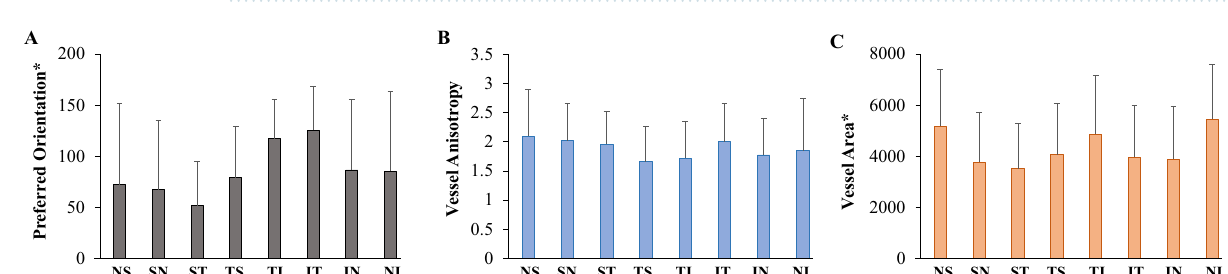
Figure 6. Sectoral difference in retinal microvascular pattern in healthy subjects (n = 34). Significant sectoral differences were observed in preferred orientation (p < 0.0001) and vessel area (p < 0.0001), whereas vessel anisotropy did not show a significant difference among the 8 sectors (p = subjects (SN: 67.2° ± 68.4° for healthy vs 62.2° ± 77.1° for DR; ST: 51.7° ± 43.1° for healthy vs 49.4° ± 31.2° for DR). The largest difference in preferred orientation between healthy and DR was observed in the IN sector (86.8° ± 69.1° for healthy vs 157.2° ± 29.4° for DR, p = 0.005). It is worth noting that due to the head–tail nature of the preferred orientation, i.e., 0° and 180° define the same line direction, when the standard deviation in a